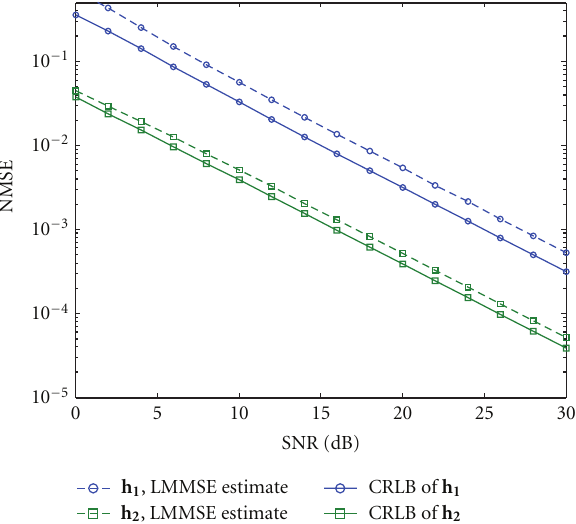
Figure 5: Channel estimation NMSEs versus SNR for α =